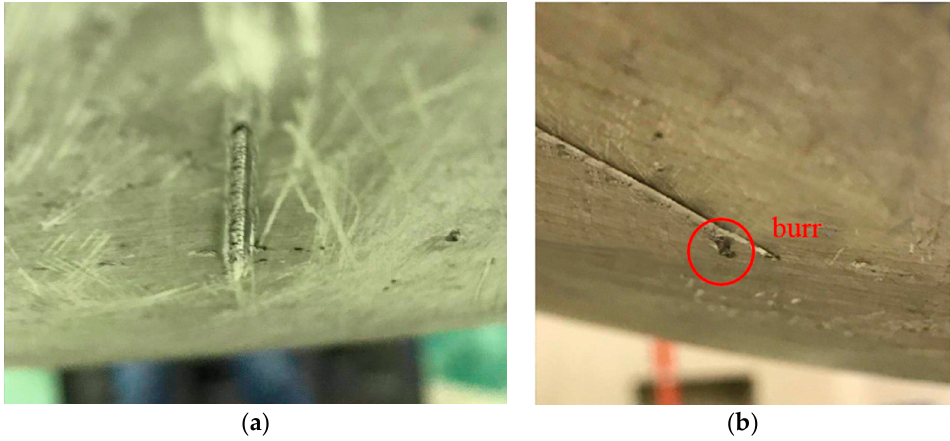
Figure 3. Arrangement of scratch: ( a ) the scratch is polished; ( b ) the scratch is not polished.